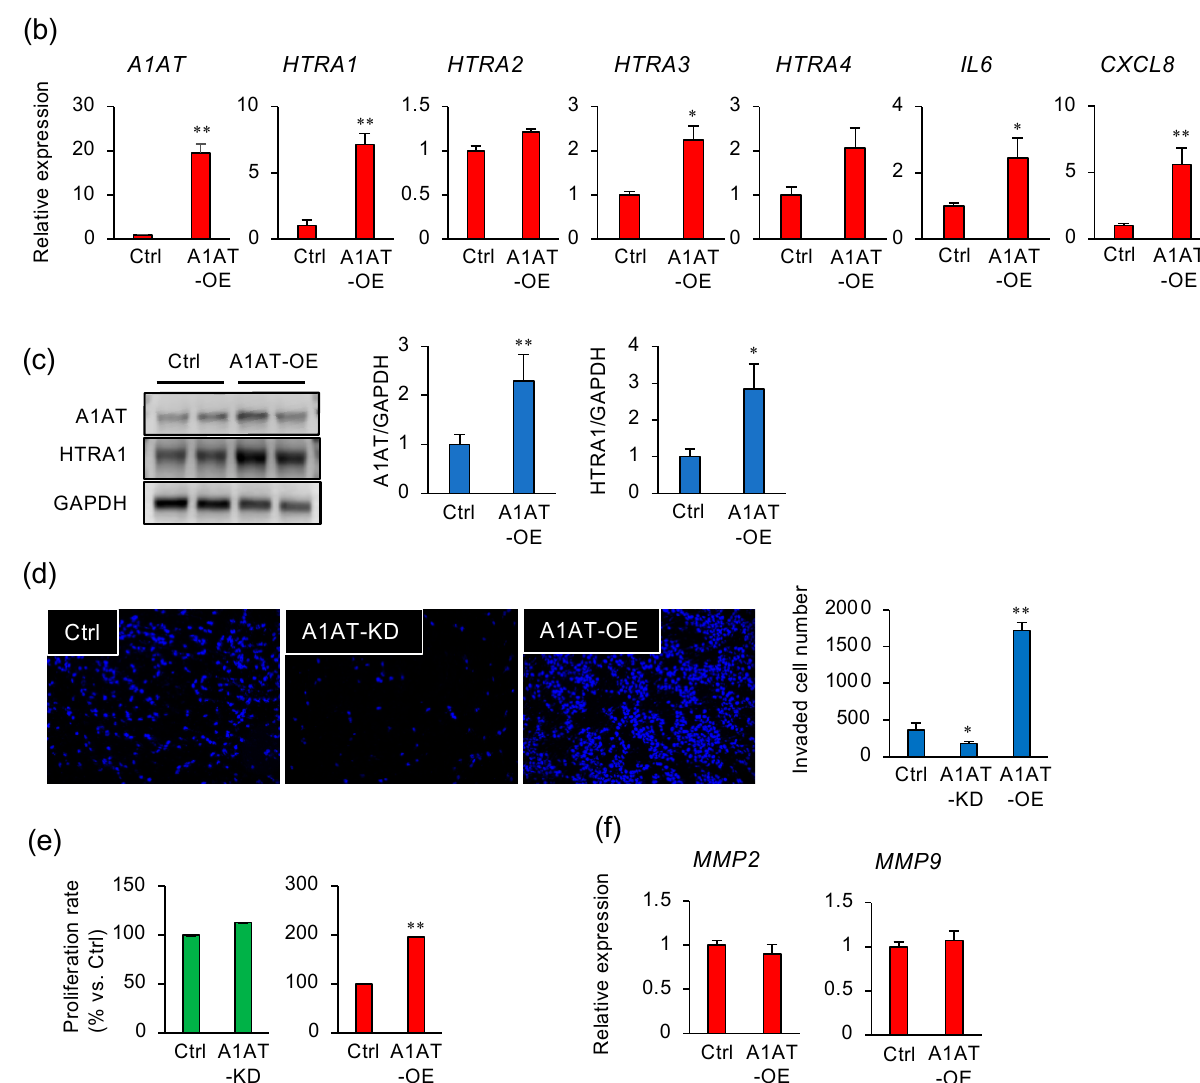
Figure 1. Alpha-1 antitrypsin (A1AT) regulates the expression of HTRA1 in an extravillous trophoblast cell line. ( a ) RNA was extracted from human extravillous trophoblast HTR8/SVneo cells that had been transfected with non-targeting control siRNA (Ctrl, 50 nM) or A1AT siRNA (A1AT knockdown (A1AT-KD), 50 nM) 24 h previously. The effect on A1AT , HTRA s, IL6 , and CXCL8 mRNA expression was determined by qPCR ( n = 3 per treatment). GAPDH mRNA was used as the reference gene. The values are the means ± SEMs of three independent experiments. * p < 0.05, ** p < 0.01. ( b ) mRNA expression of A1AT , HTRA s, IL6 , and CXCL8 in HTR8/SVneo cells that had been transfected with an empty vector (Ctrl) or an A1AT expression vector (A1AT overexpression (A1AT-OE)). GAPDH mRNA was used as the reference gene. The values are the means ± SEMs of three independent experiments. * p < 0.05, ** p < 0.01. ( c ) Lysates prepared from HTR8/SVneo cells treated as above were subject to immunoblotting. GAPDH served as the loading control. The values are the means ± SEMs of three independent experiments. * p < 0.05, ** p < 0.01. ( d ) A1AT-KD and A1AT-OE HTR8/SVneo cells were incubated in Matrigel-coated transwells for 48 h. Representative images of the cells that passed through the transmembranes are shown in the panels on the left. The numbers of cells that passed through the transmembranes were counted and are presented as the means ± SEMs of the three independent experiments. * p < 0.05, ** p < 0.01. ( e ) A1AT-KD or A1AT-OE HTR8/SVneo cells were cultured for 48 h and the numbers of cells were determined using a WST-8 assay. ** p < 0.01. ( f ) The expression of MMP2 and MMP9 in A1AT-OE HTR8/SVneo cells was measured. GAPDH was used as the reference gene. The values are the means ± SEMs from three independent